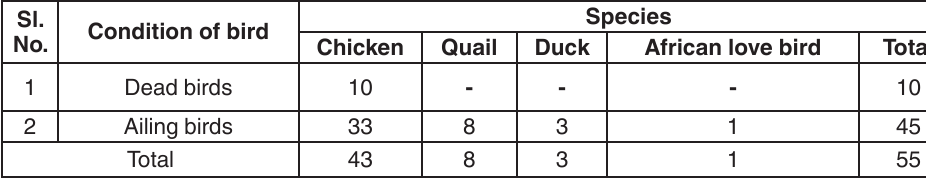
table 1. Details of the samples collected sl. No.